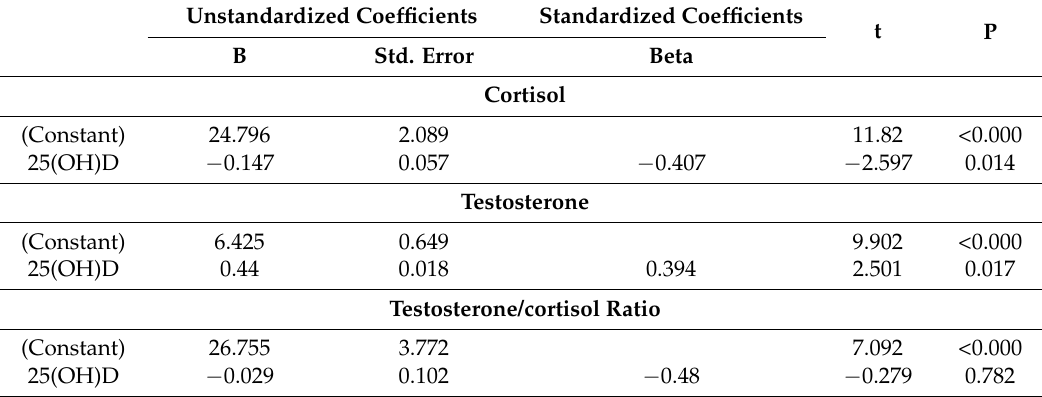
Table 7. Regression multivariate analysis with catabolic–anabolic hormones as the dependent variable and 25(OH) D as